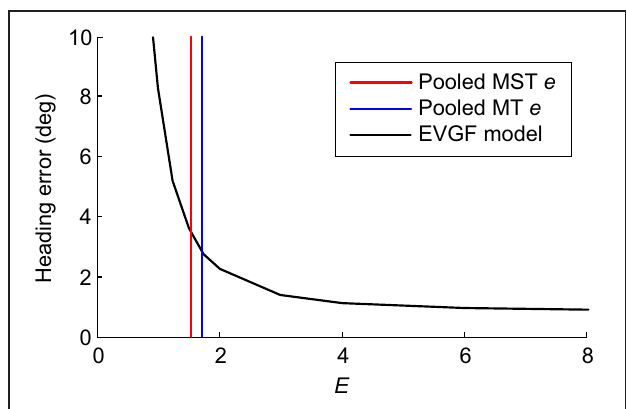
FIGURE 7 | Heading error (i.e., under-compensation for pursuit) in the elaborated velocity gain field (EVGF) model as a function of E , the amount of local constraint line tuning. Pursuit-compensation starts to saturate at a realistic level from E ≈ 3. The vertical lines indicate the values of e observed in our pooled MT and MST samples. This analysis suggests that e is not sufficient to support constraint line tuning as proposed in the velocity gain field